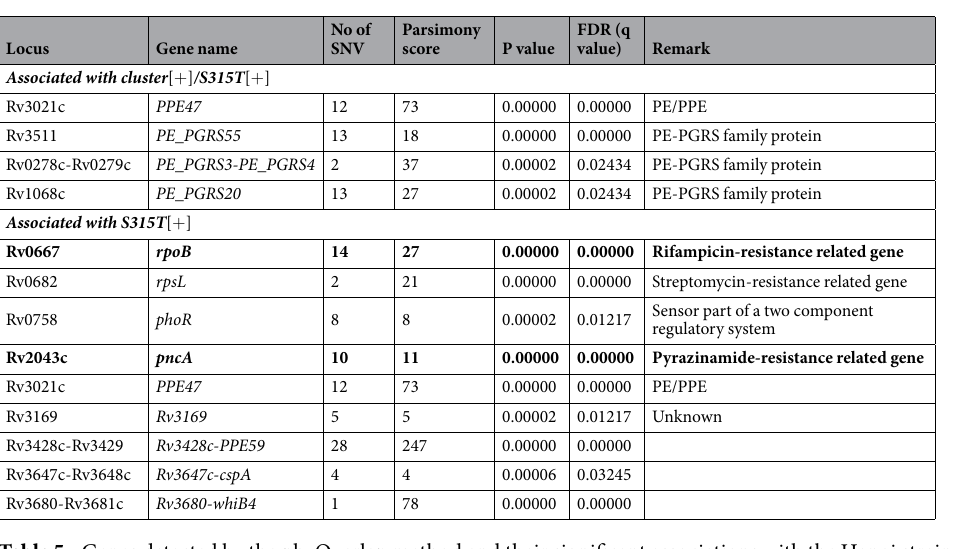
Table 5. Genes detected by the phyOverlap method and their significant associations with the Hanoi strains harboring the katG -S315T mutation, with and without clustering, and loci shared with the KwaZulu-Natal study population. The genes in bold are shared between Hanoi and KwaZulu-Natal study